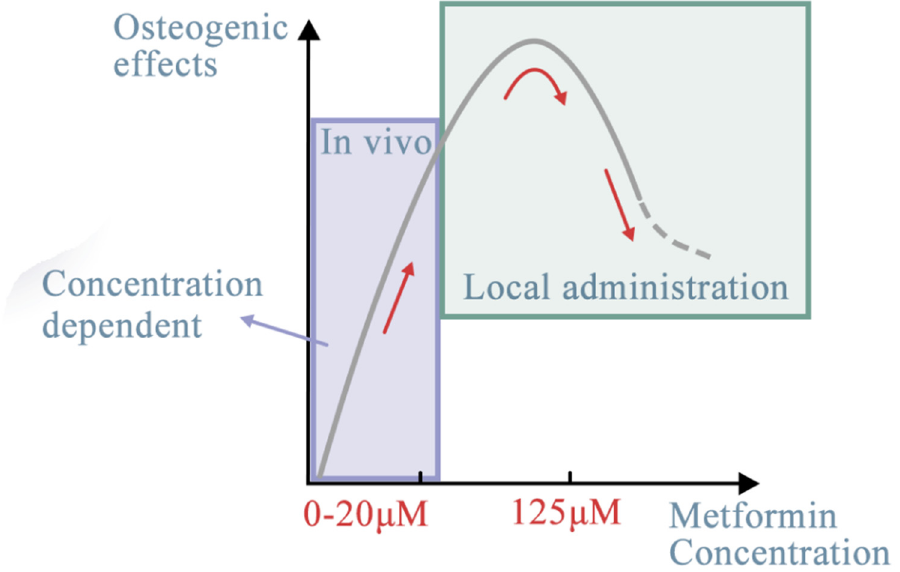
Figure 3. Effects of metformin concentration on different target stem cells. The optimal concentration of metformin, ranging from 0.5 to 500 µ M, could have better osteogenic effects through the AMPK signaling pathway. With different target stem cells, in vivo or in vitro (local administration), the dose-dependent effect may be different (red line). The effects of metformin, despite regulating more or less the same signaling pathways, differ depending on the target tissues [37], whether they are stem cells or non-cell materials. For seed cells, it mostly depends on their cellular origin and osteogenic lineage. In this section, we discuss the potential targeted seed cells from within or outside of the oral cavity. The oral cavity is a special environment for targeted stem cells. Its complexity derives from its composition [38]. For example, the periodontal complex consists of hard tissues (alveolar bones, cementum), soft tissues (periodontal ligament fibers, gingival tissues), blood ves- sels, and nerves [39]. Other than non-cell materials, stem cells are categorized into six sources: MSCs, dental-derived cells, BMSCs, hi-PSCs, cancer cells, and immune cells. In the following section, each of these sources is reviewed.